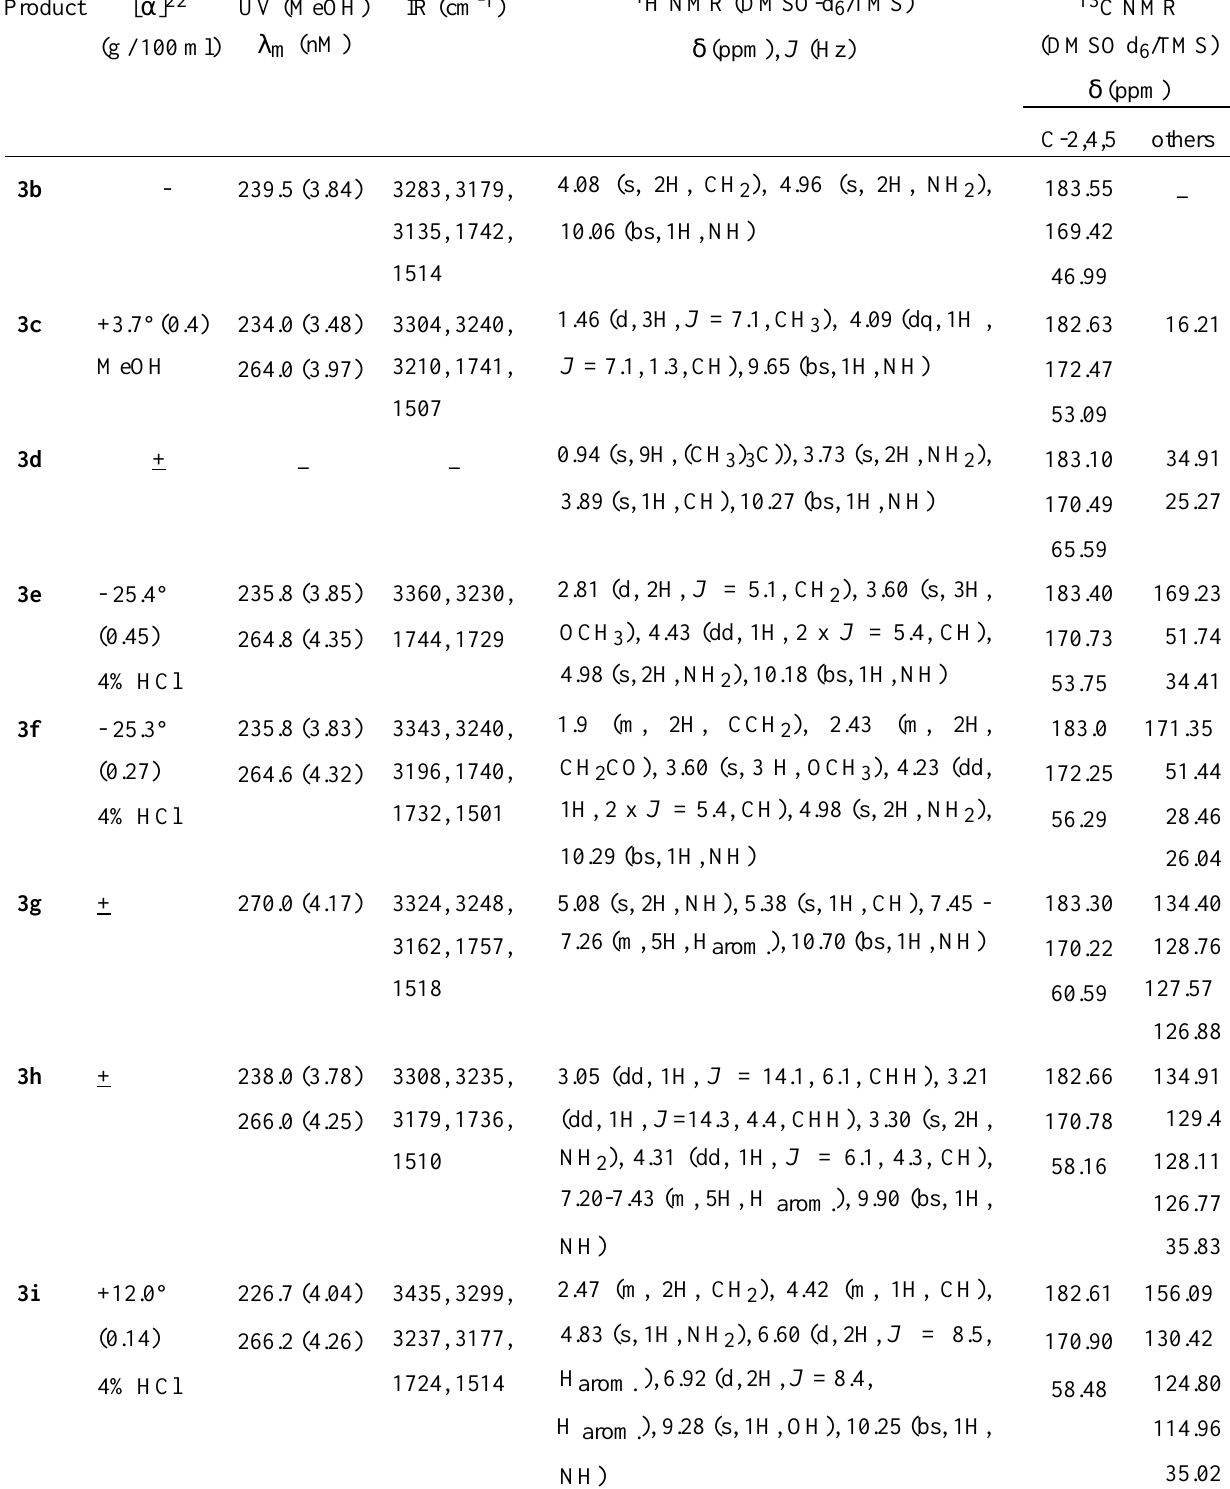
Table 2. Spectral data of 3-Aminothiohydantoins 3